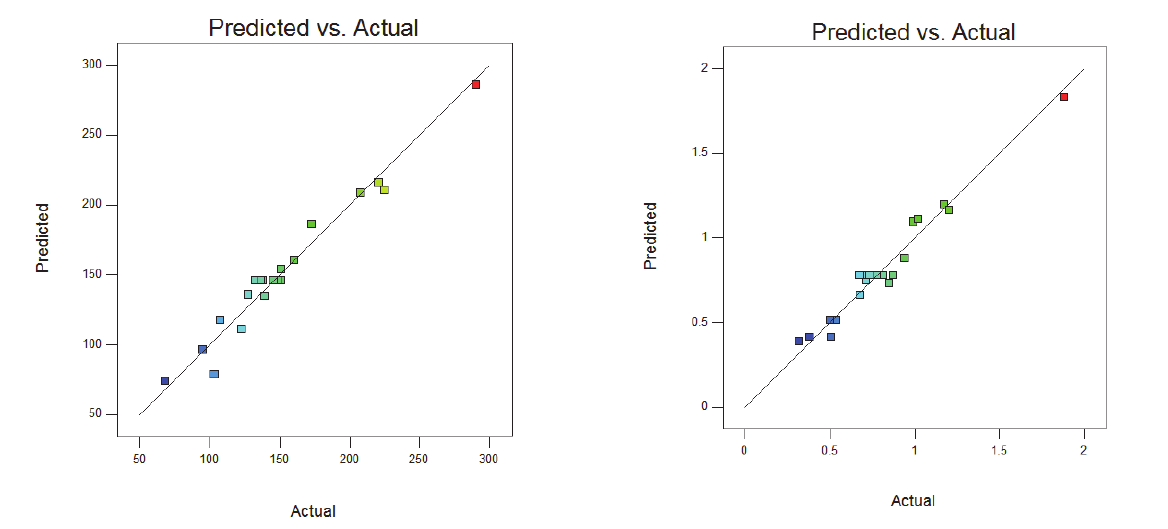
Fig. 1 . Comparison between measured and predicted values for tool wear